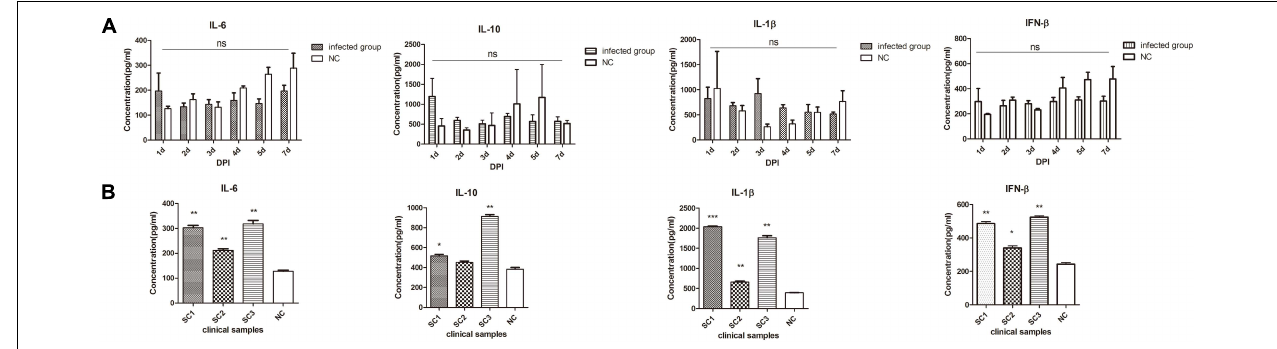
FIGURE 3 | Differential expression of cytokines in the early and late phases of ALV-J infection. (A) IL-6, IL-10, IL-1 β , and IFN- β cytokine expression measured by ELISA between the infected chick group and the control group (NC). (B) . Cytokine expression measured by ELISA in chickens with neoplasms (SC1–3) and uninfected control (average of NC group, n = 3). ∗ p < 0.05, ∗∗ p < 0.01, ∗∗∗ p < 0.001.